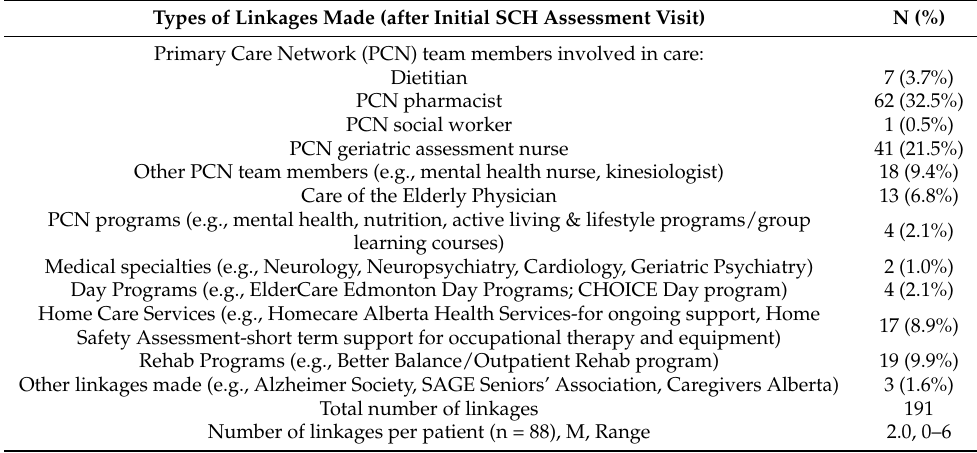
Table 3. Health, social & community services linkages made by SCH clinic